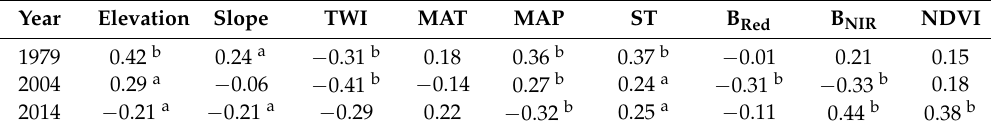
Table 3. Correlations between the TN concentration and environmental variables.